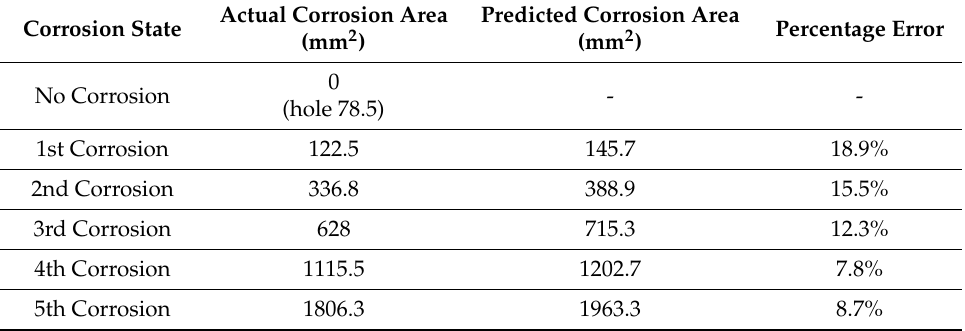
Figure 15. Comparison of five times real corrosion damage and predicted damage, from ( a ) to ( e ). Table 6. Corrosion state and corrosion area measurement results.